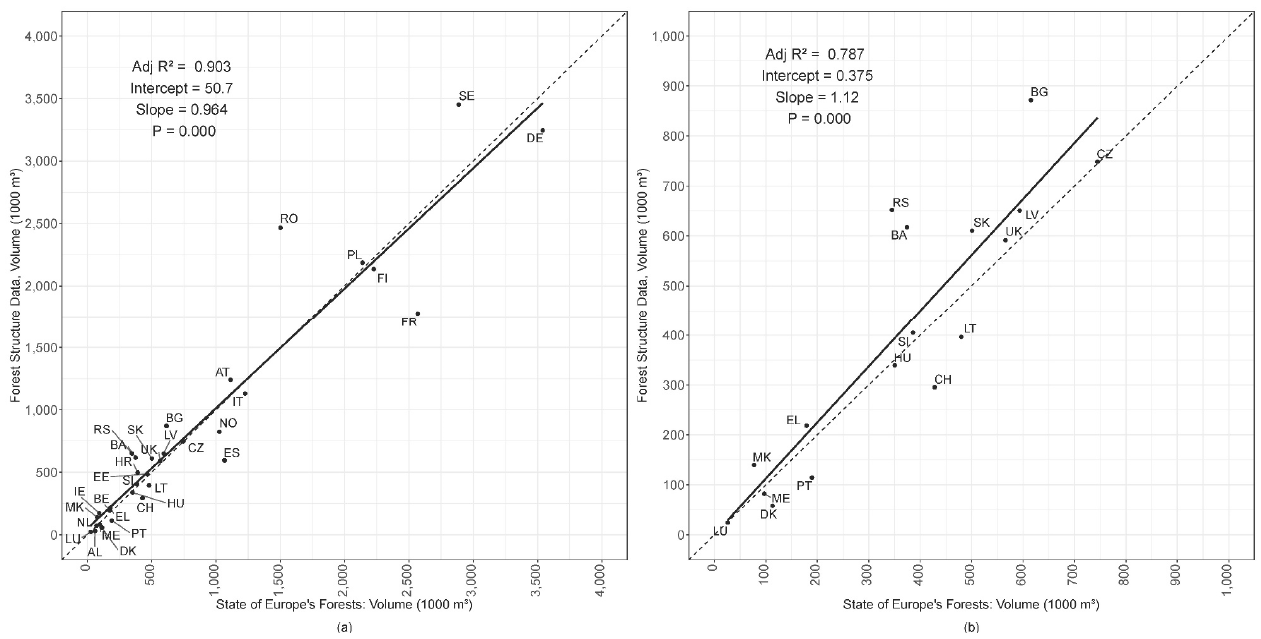
Figure 11. Comparison of the volume calculated from our Forest Structure Data versus the mean of the volumes for the period 2000 to 2010 as reported in State of Europe’s Forest 2015 [3] (Ind 1.2B Change in growing stock on forests). Forest Structure Data refers to the values calculated by combining the gap-filled maps with land cover information to calculate country totals (see Figure 7). Linear regression results R² (Adj R²), Intercept, Slope and p − Value (P) are shown. ( a ) Shows results when using all countries, irrespective if National Forest Inventory (NFI) data were available. ( b ) Shows the results only for countries where no NFI data were available. Country codes are: AL = Albania, AT = Austria, BA = Bosnia − Herzegovina*, BE = Belgium, BG = Bulgaria*, CZ = Czech Republic*, CH = Switzerland*, DE = Germany, DK = Denmark*, EE = Estonia, EL = Greece*, ES = Spain, FI = Finland, FR = France, HR = Croatia, HU = Hungary*, IE = Ireland, IT = Italy, LT = Lithuania*, LU = Luxemburg*, LV = Latvia*, ME = Montenegro*, MK = North Macedonia*, NL = Netherlands, NO = Norway, PL = Poland, PT = Portugal*, RO = Romania, RS = Serbia*, SE = Sweden, SI = Slovenia*, SK = Slovakia*, UK = United Kingdom*; Countries where no inventory data were present are marked with an asterisk.